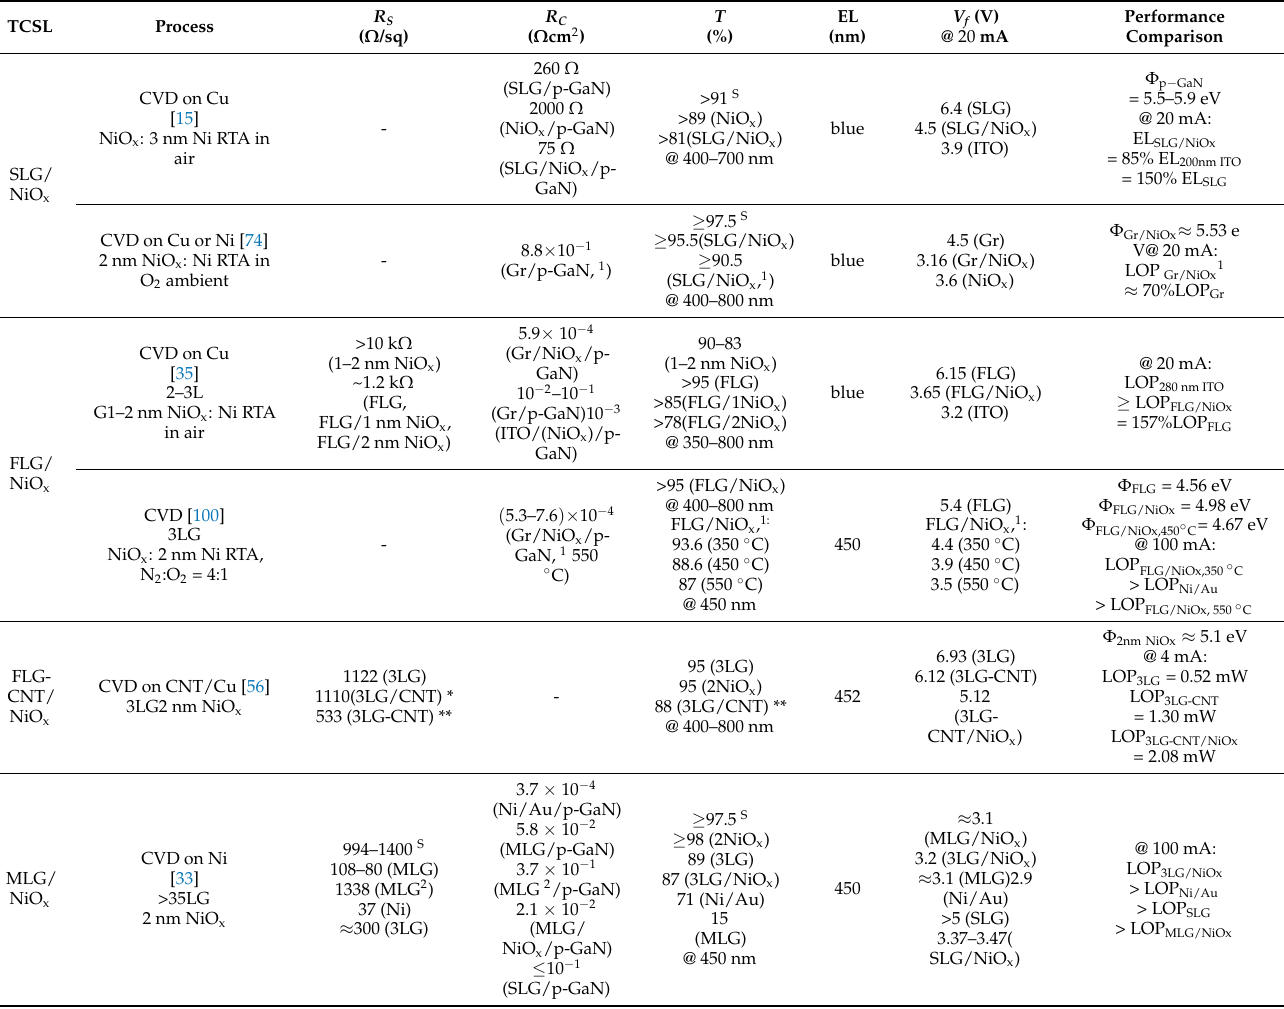
Table 6. Usage of graphene combined with NiO x as TCSL in GaN-based